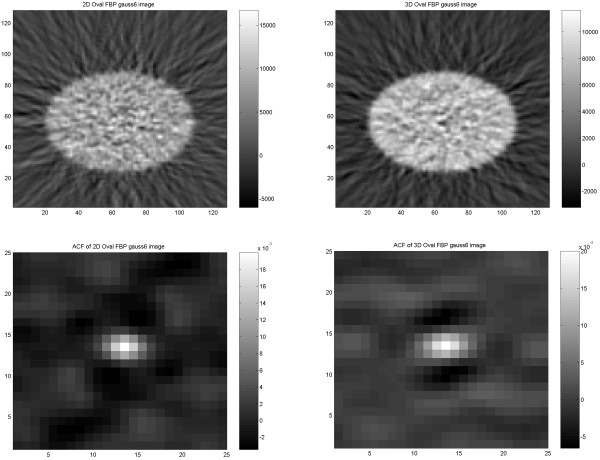
Results of the elliptical torso phantom study. 2D image (upper left) and 3D image (upper right) reconstructed using FBP with applied 6 mm (FWHM) Gaussian filter. Corresponding ACF images of 2D (lower left) and 3D image (lower right).